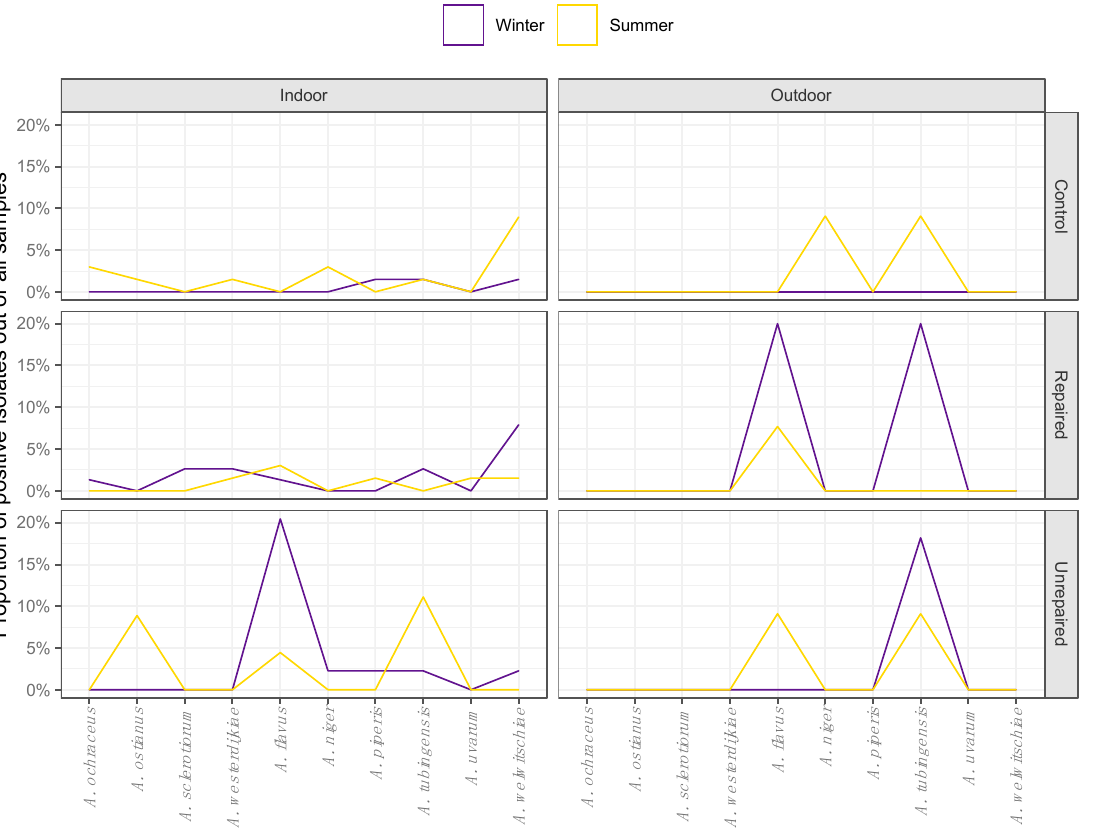
Figure 3. Seasonal distribution patterns of Aspergilli from the sections Circumdati (A. ochraceus, A. ostianus, A. sclerotiorum, and A. westerdijkiae), Flavi (A. flavus) and Nigri (A. niger, A. piperis, A. tubingensis, A. uvarum, and A. welwitschiae) in indoor and outdoor air during winter and summer sampling periods in repaired houses, unrepaired houses, and control houses.